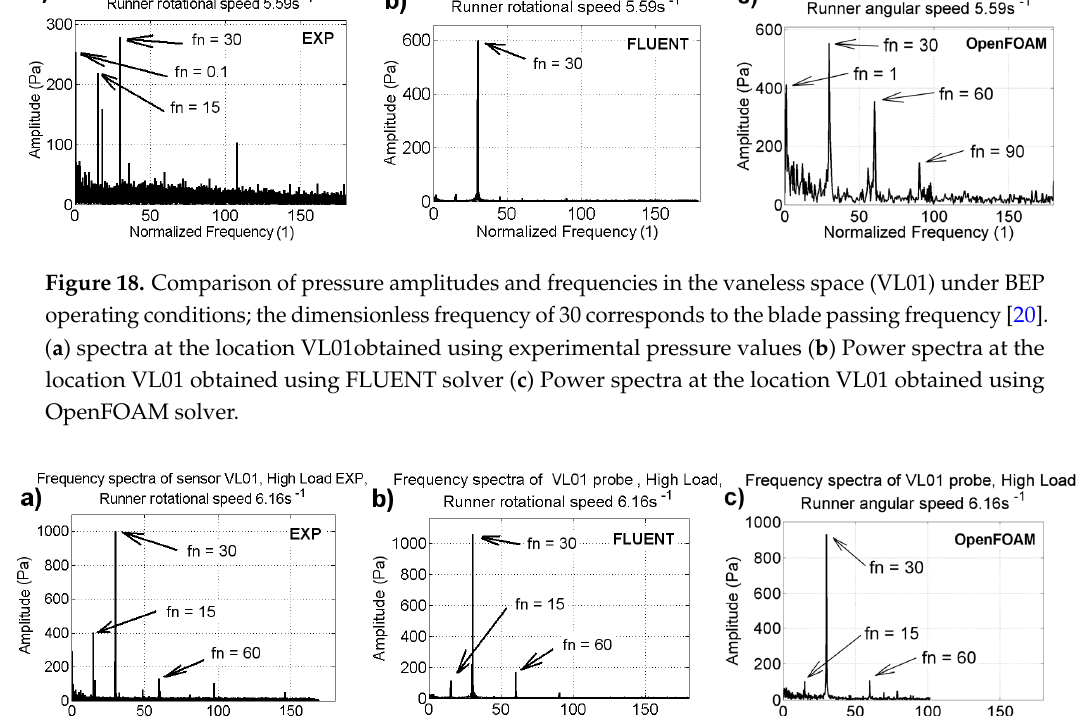
Figure 19. Comparison of pressure amplitudes and frequencies in the vaneless space (VL01) under high load operating conditions; the dimensionless frequency of 30 corresponds to the blade passing frequency [20]. ( a ) Power spectra at the location VL01 obtained using experimental pressure values ( b ) Power spectra at the location VL01 obtained using FLUENT solver ( c ) Power spectra at the location VL01 obtained using OpenFOAM solver